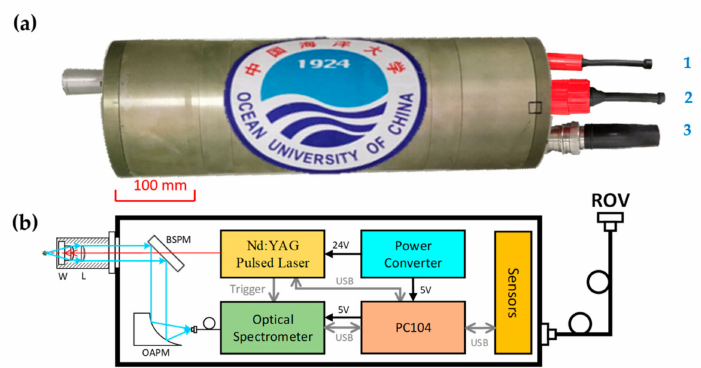
Figure 1. ( a ) The photo of the newly developed underwater LIBS device (LIBSea II). ( b ) Schematic of the LIBSea II system showing the optical layout, pulsed laser, optical spectrometer, embedded computer, power converter and environment